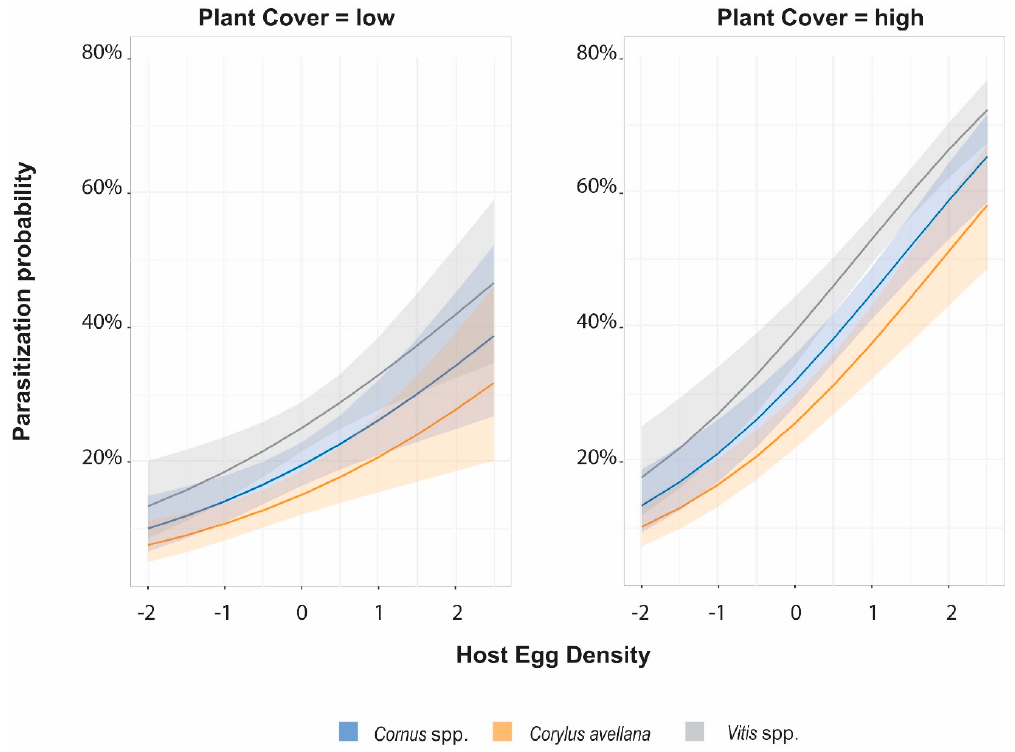
Figure 1. Predicted probability of egg parasitization for three Plant Species, with respect to standardized Plant Cover and standardized Host Egg Density (number of M. pruinosa eggs per Plant Species in each site). The percentage of Plant Cover was modeled as continuous variable. Two